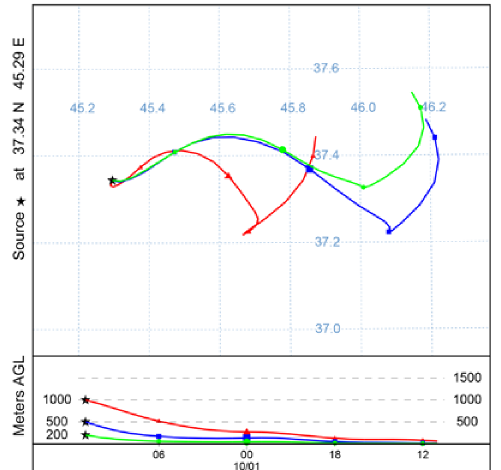
Figure 7 NOAA HYSPLIT backward trajectories ending in Rashakan, at 11:00 UTC, Oct. 01,